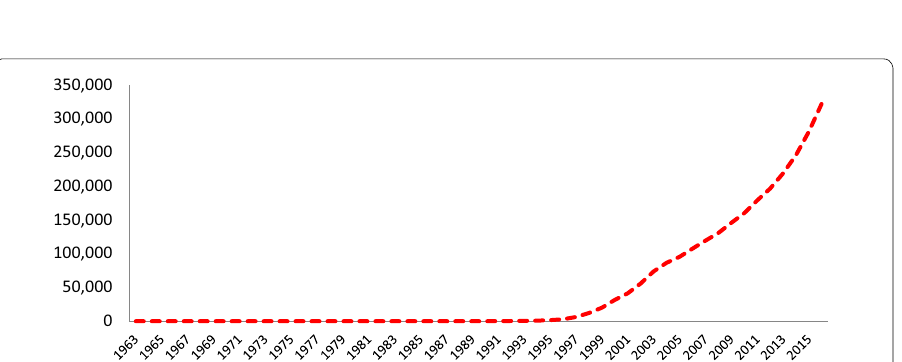
100) was calculated by deriving data =